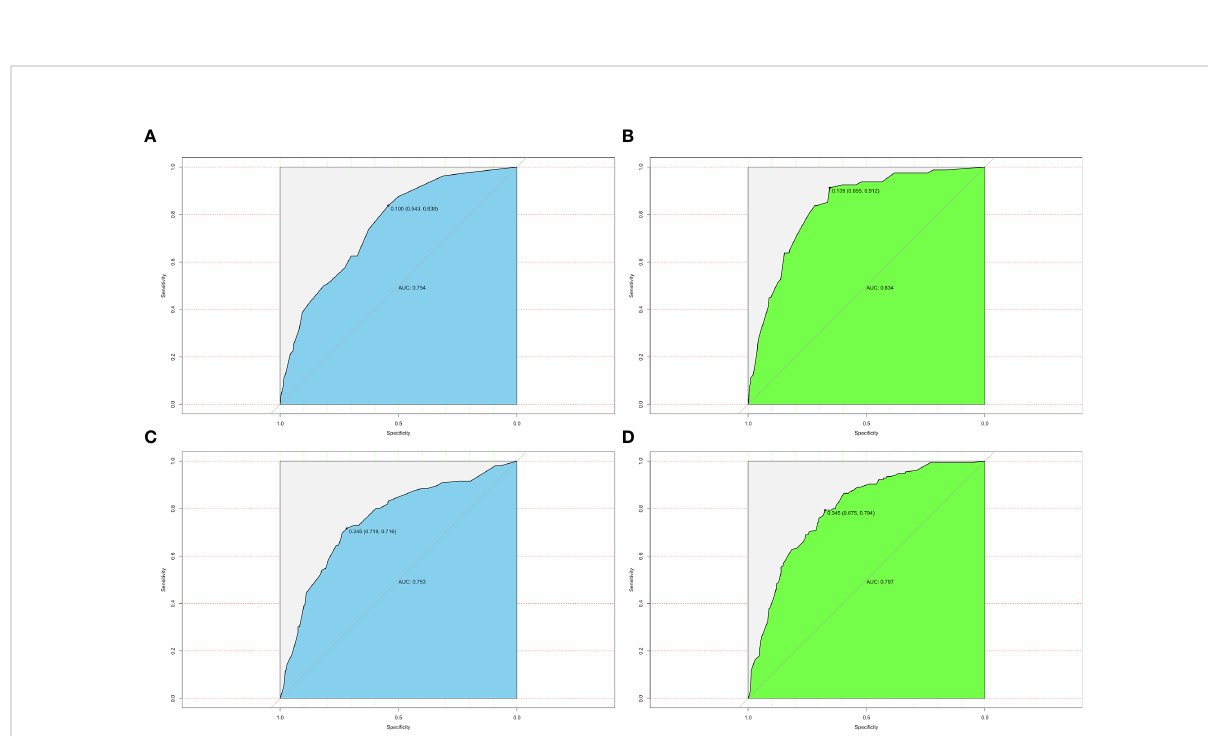
FIGURE 4 ROC curves for different models. (A) AUC was 0.754 for the preoperative model of predicting LLNM in PTMC patients; (B) AUC was 0.834 for the postoperative model of predicting LLNM in PTMC patients; (C) AUC was 0.753 for the preoperative model of predicting LLNM in macro-PTC patients; (D) AUC was 0.797 for the postoperative model of predicting LLNM in macro-PTC